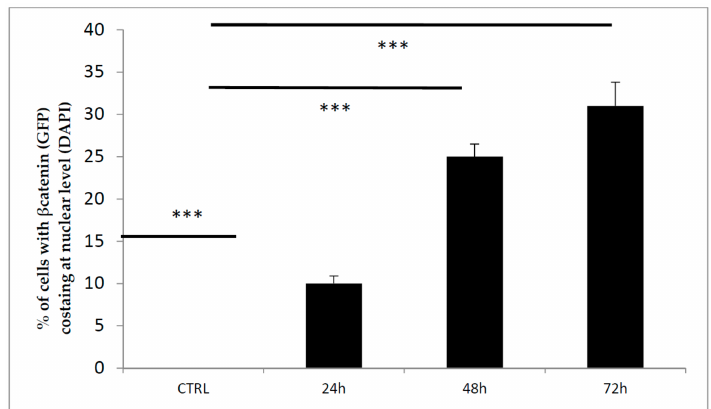
Figure 5. The bars chart shows the percentage of cells expressing Green fluorescent protein (GFP) at nuclear level normalized on total cell number revealed by DAPI staining. *** p < 0.05.